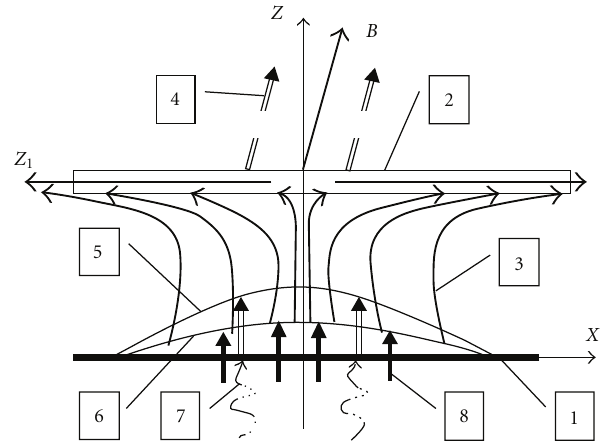
Figure 6: Schematic model used for the calculation of elec- tric field due to the injection of charged aerosols in the atmosphere-ionosphere circuit. 1—Earth’s surface, 2—ionosphere, 3—conducting current in the atmosphere and the ionosphere, 4— field-aligned current, 5—zone of upward convection of charged aerosols and external electric current formation, 6—zone of perturbation of atmospheric conductivity induced by radioactive elements emanation, 7—charged aerosols moving upward with soil gases, 8—radioactive elements emanation, credit